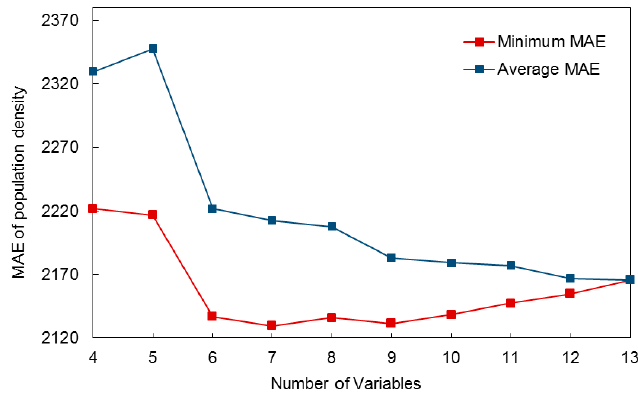
Figure 7. Variations of the minimum and average mean absolute error (MAE) with the number of variables.